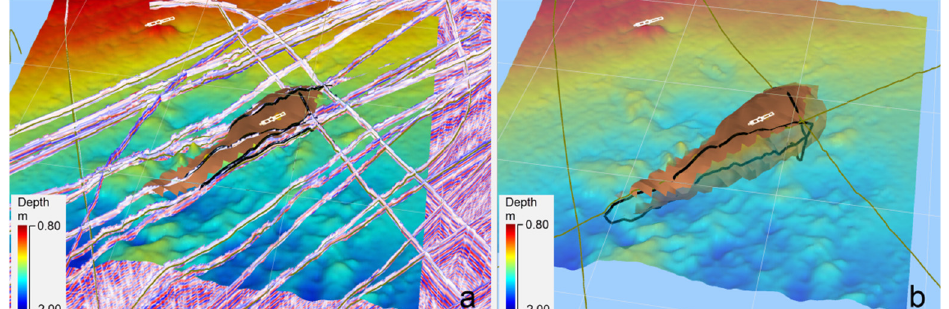
Figure 9. A 3D model of the wreck ruins across the ‘shipwreck site 1’. ( a ) Interpretations of shipwreck ruins (manual picks in black) from acoustic profiles; ( b ) A 3D representation of the shipwreck (in brown) and interpretation of wreck ruins from two seismic sections. Grid cell size (in white): 10 m × 10 m.